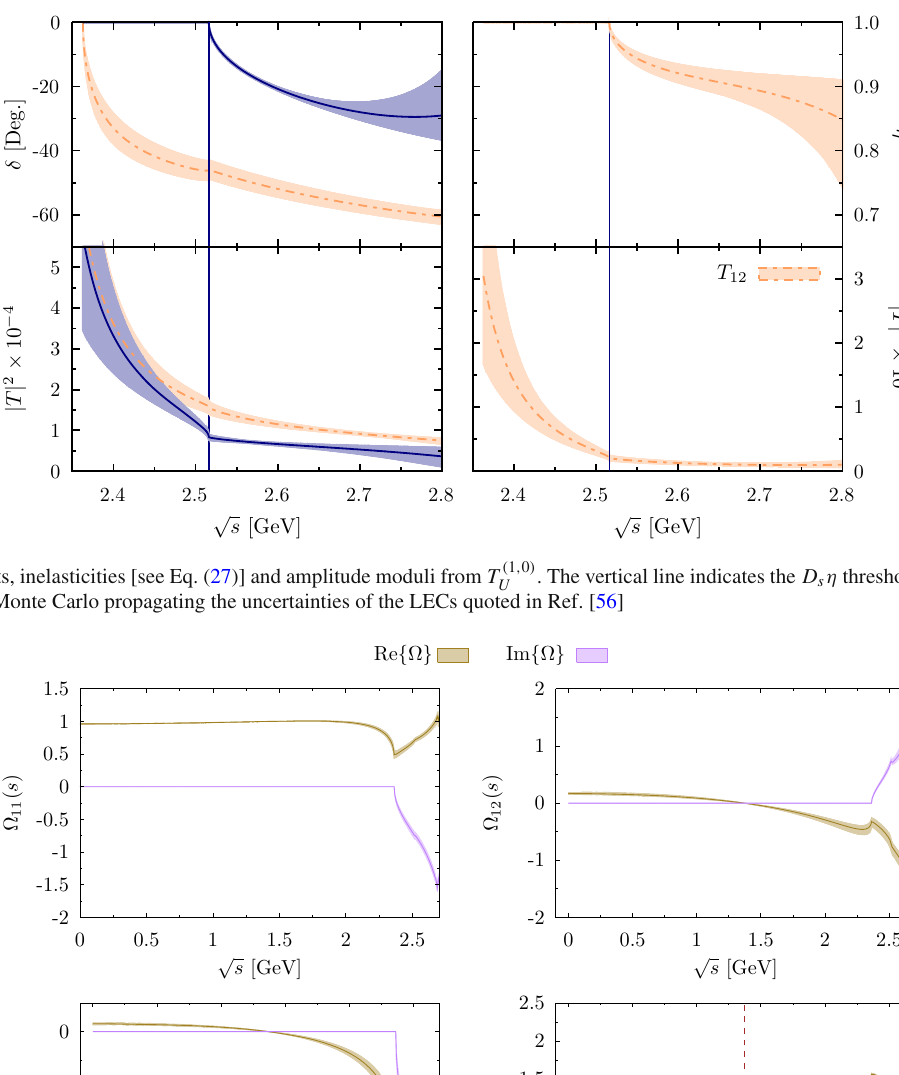
Fig. 2 ( S , I ) = ( 1 , 0 ) Omnès matrix solution of the MO integral equation (20) with the contour condition (cid:15) asymptotic phase shifts δ DK ( ∞ ) = 2 π and δ D